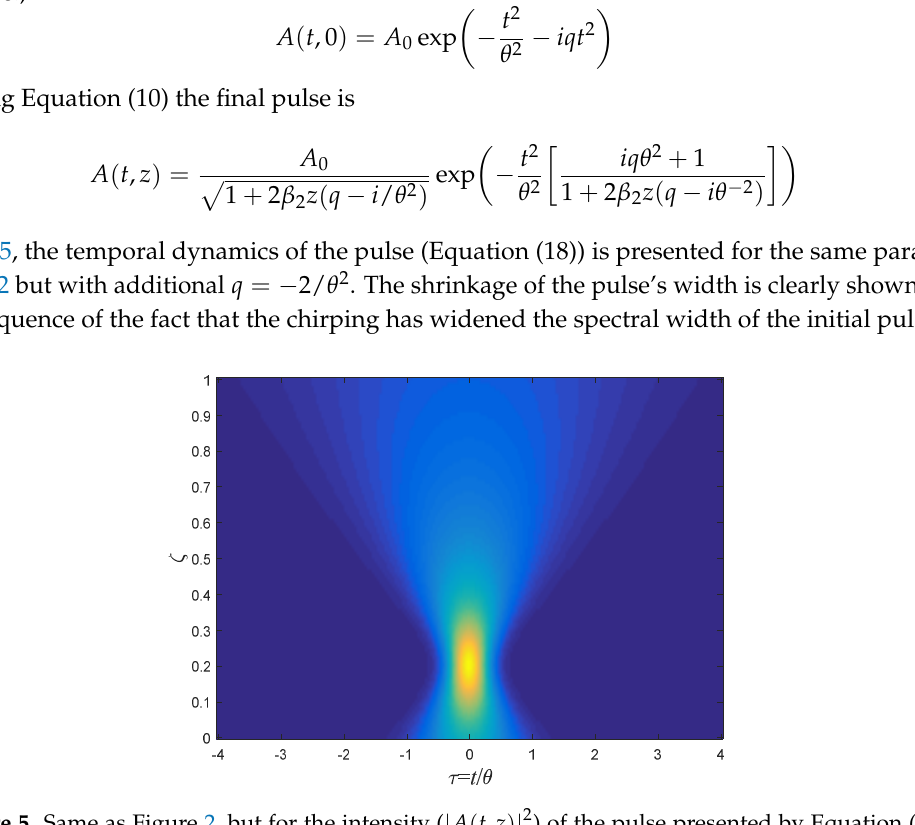
Figure 5. Same as Figure 2, but for the intensity ( | A ( t , z ) | 2 ) of the pulse presented by Equation (18) (in this example, q = − 2/ θ 2 ).